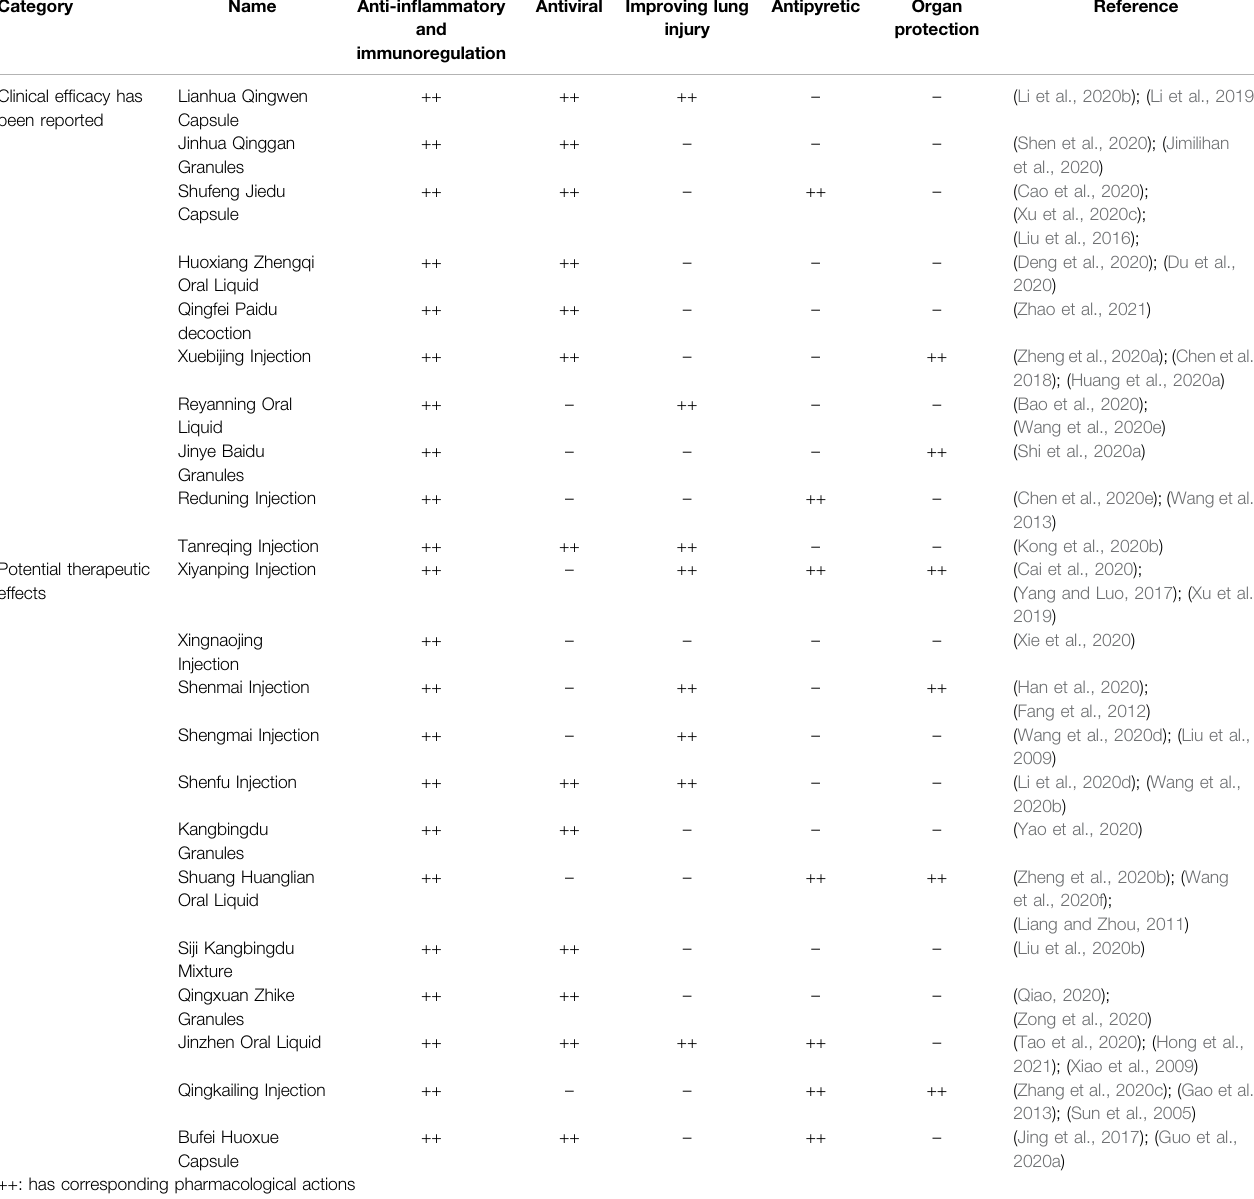
TABLE 4 | The pharmacological action of CPMs for the treatment of